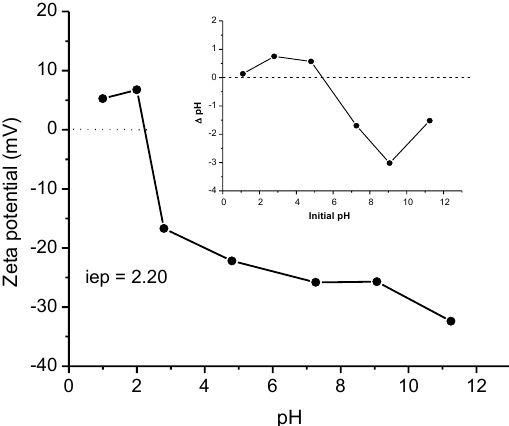
Figure 3. Zeta potential and point of zero charge of the P. koidzumii sorbent.